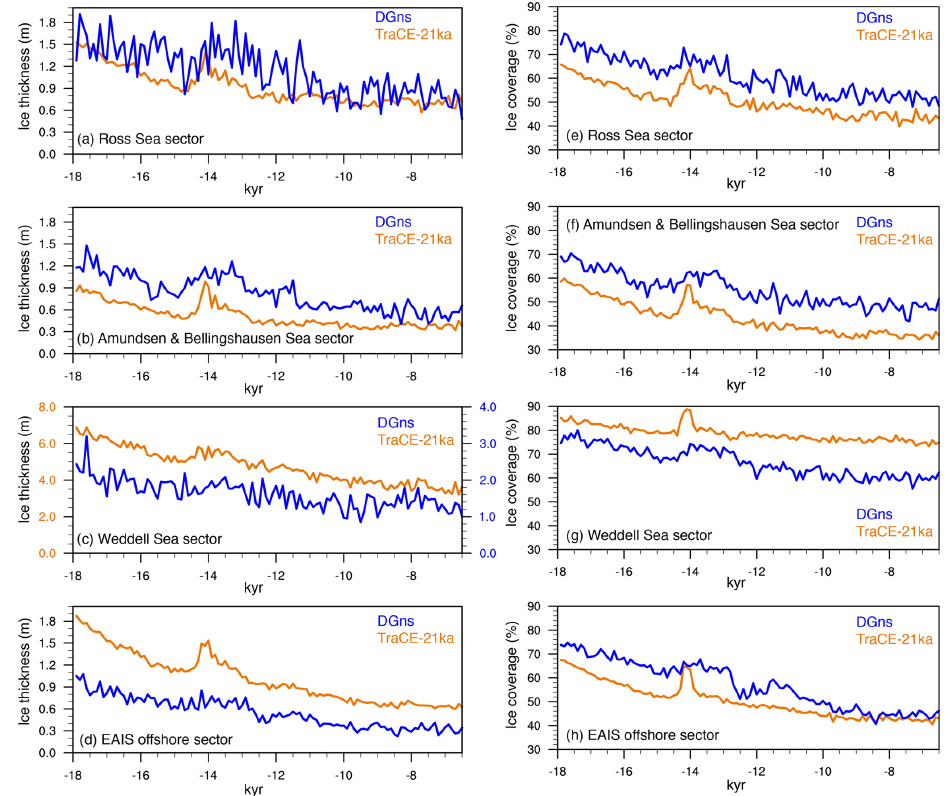
Figure 10. Time series of 100-year mean annual average (a–d) sea ice thickness (m) and (e–h) coverage (%) in the Southern Ocean, namely the Ross Sea sector (70–50 ◦ S, 168 ◦ E–160 ◦ W), the Amundsen and Bellingshausen Sea sector (68–50 ◦ S, 135–60 ◦ W), the Weddell Sea sector (70–50 ◦ S, 60–30 ◦ W), and the offshore EAIS sector from Lazarev Sea to Somov Sea (67–50 ◦ S, 15 ◦ W–165 ◦ E). Please note the difference in scale in panel (c)